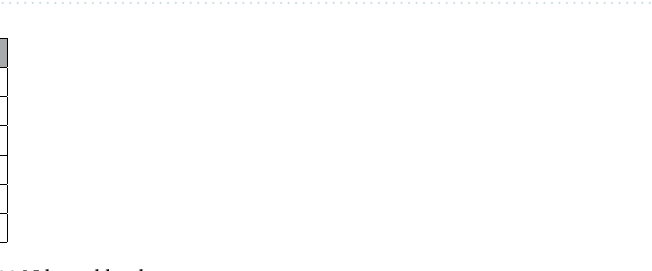
Table 1. Response of the track to a 200 N lateral load.